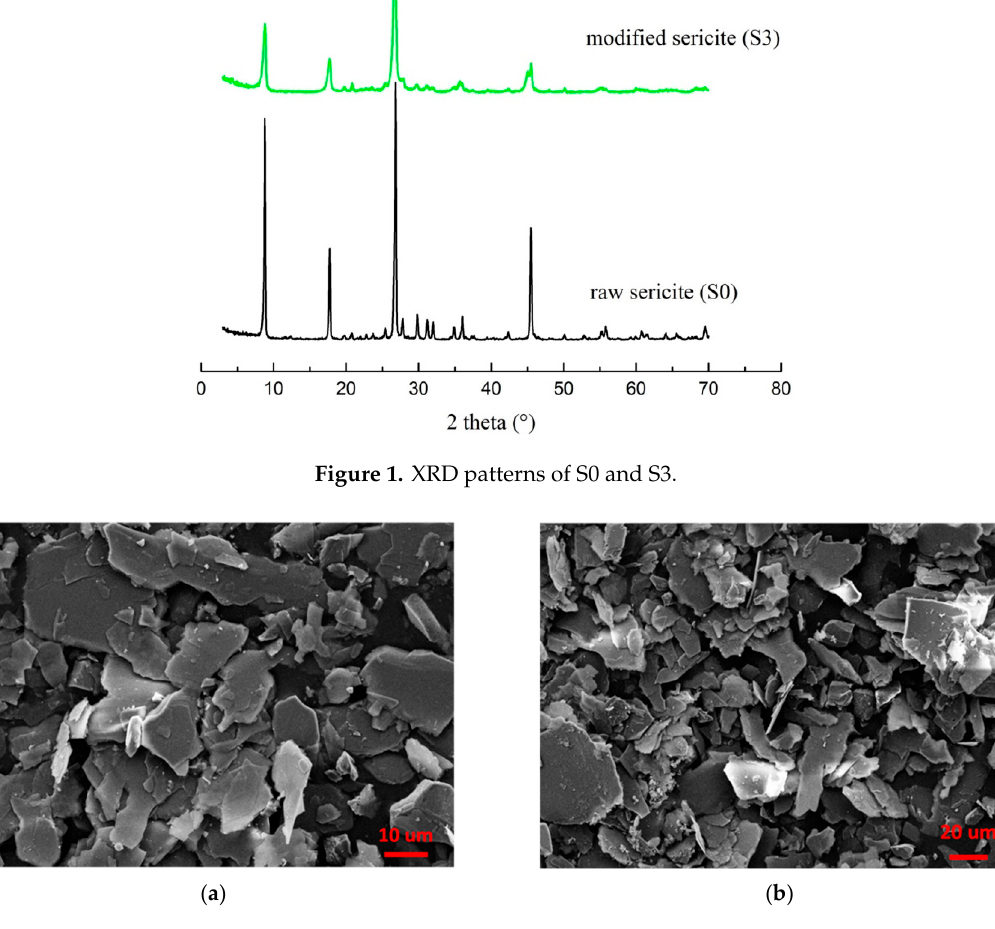
Figure 2. SEM images of ( a ) S0 and ( b ) S3.